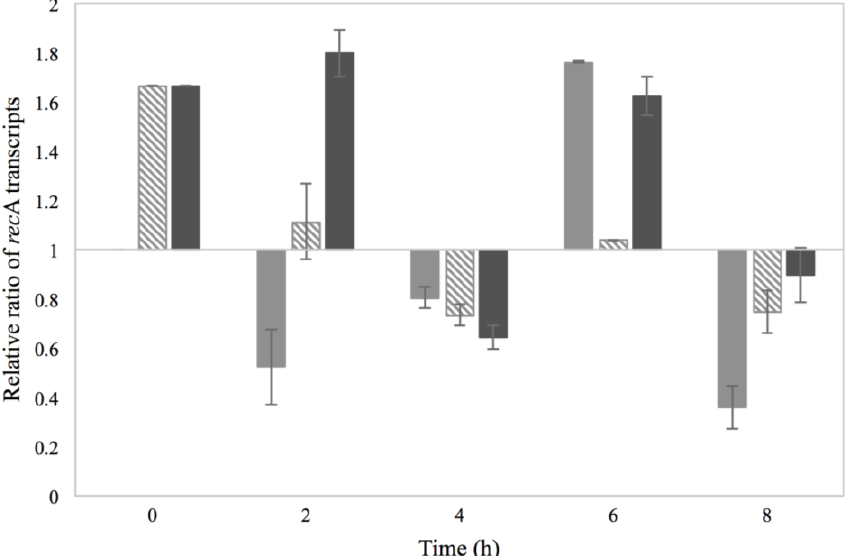
Figure 8. Relative rec A mRNA transcript levels formed in batch cultivation of Sa17 cells under exposure to either NaCl stress or optimal conditions. The cells were pre-grown under optimal and NaCl stress. The Y axis represents the rec A relative ratio levels in reference to the condition Co–Co, as calculated from Cq values obtained from one independent experiment, and the X axis represents the time in h. The different growth conditions are designated: Co–Na ( ), Na–Co ( ) and Na–Na